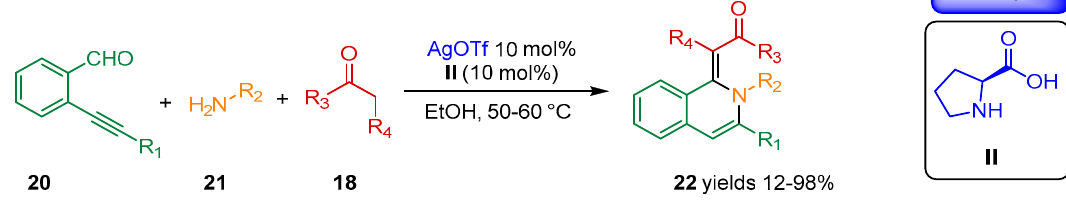
Scheme 7. Synergistic catalysis mediated by silver-based and proline catalysis.